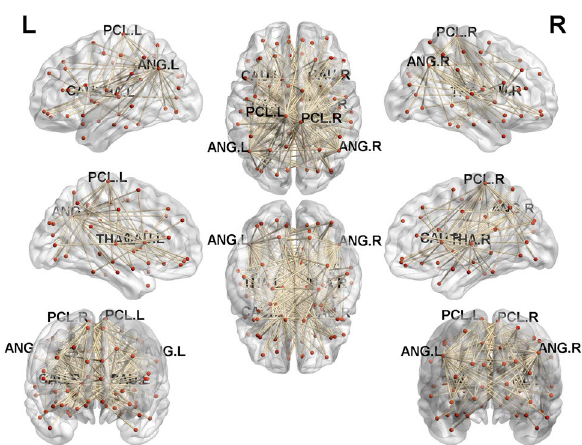
Figure 1. Significant connections rendered on the surface of the automated anatomical labeling atlas in BrainNet viewer. THA thalamus, ANG angular gyrus, CAU caudate nucleus, PCL paracentral lobule, L left, R